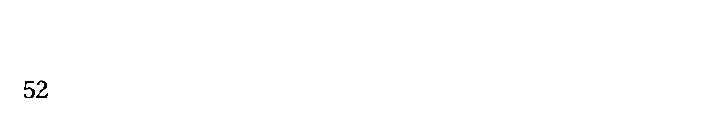
voor omdat geen variasie in sinsvorm vereis word nie. Neweskikkende sinne sluit ook die gebruik van die voeg- woord "en" in, en volgens Schwartz en Solot (1980) is "en" een van die eerste en mees algemene voegwoorde wat deur die gehoorgestremde kind gebruik word. Volgens Schmitt (1970) is die gehoorgestremde kind nie geneig om passiewe sinne, ontkenningsinne of enige ander sinne wat variasie in vorm vereis, te gebruik nie. Simmons (1962) meen ook dat die gehoorgestremde min buigbaarheid toon ten opsigte van sinstrukture, en die afwesigheid van sinne soos die passiewe vorm of ingebedde sin in die resultate kan moontlik hieraan toegeskryf word. Die produksie van saamgestelde sinne is vir die gehoorgestremde kind moeilik en daarom word kort eenvoudige sinne gebruik, wat die klein persentasie (2%) onderskikkende sinne van die resultate verklaar (Lewis en Wilcox, 1978). Pressnell (1973) is van mening dat die ge- hoorgestremde se bemeestering van sintaksis in gesproke taal vertraag is, en sy bevindinge word gestaaf deur huidige bevindinge.